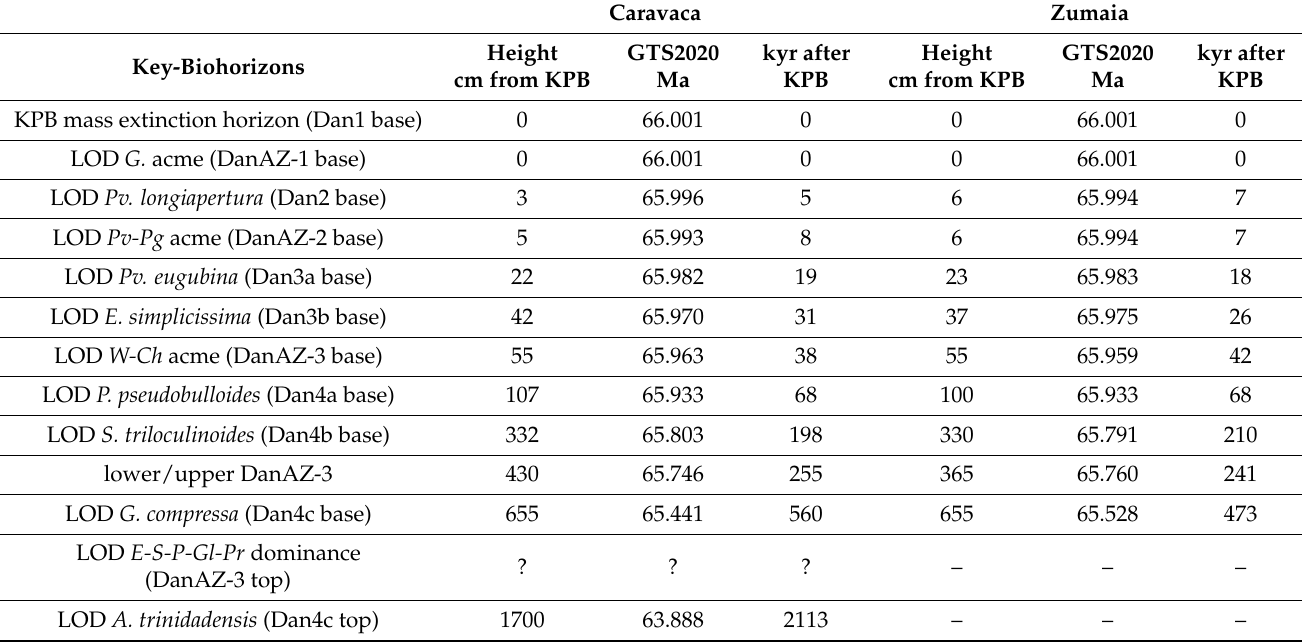
Table 2. Magnetochronological and astronomical calibrations of Danian planktic foraminiferal key biohorizons in the Caravaca and Zumaia reference sections. Stratigraphic position (cm from the KPB) of key-biohorizons, and their calibrated ages (in Ma and kyr after the KPB). ?: